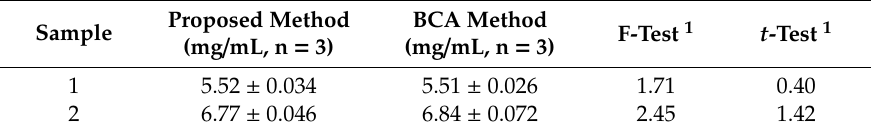
Table 5. The results of cell total